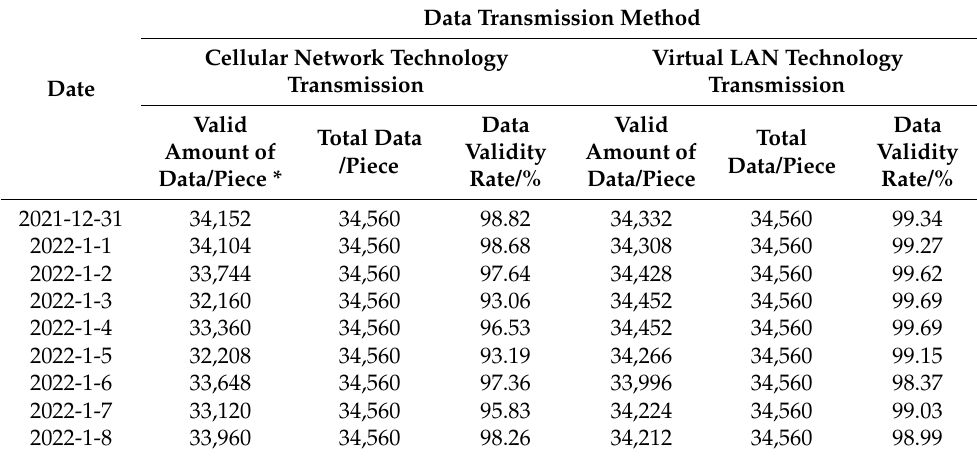
Table 3. Analysis of valid data transmitted by two transmission